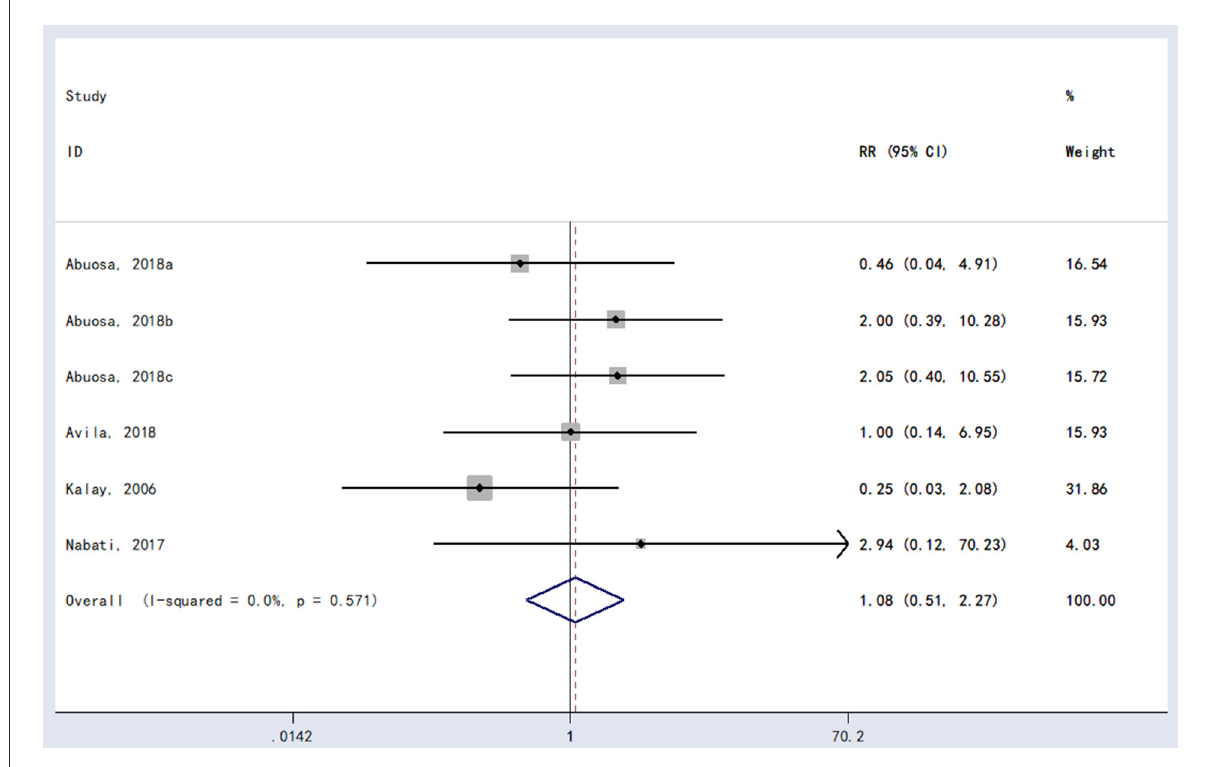
FIGURE4 Forest plot of Carvedilol’s impact on